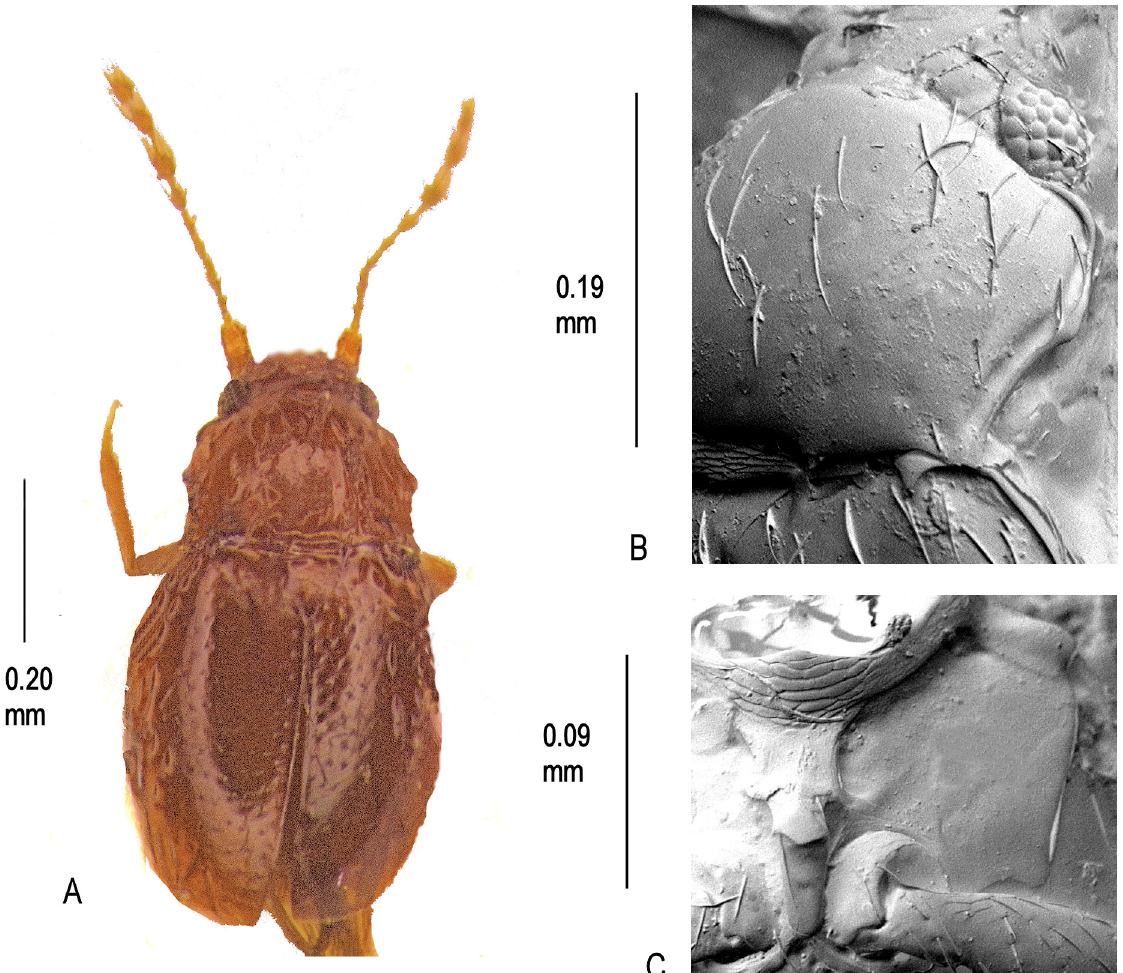
Fig. 104 . Cissidium similatum sp. nov. A . Habitus. B . Pronotum, × 400. C . Mesoventrite showing median process of collar, lateral margin, mid-keel and keel, ×